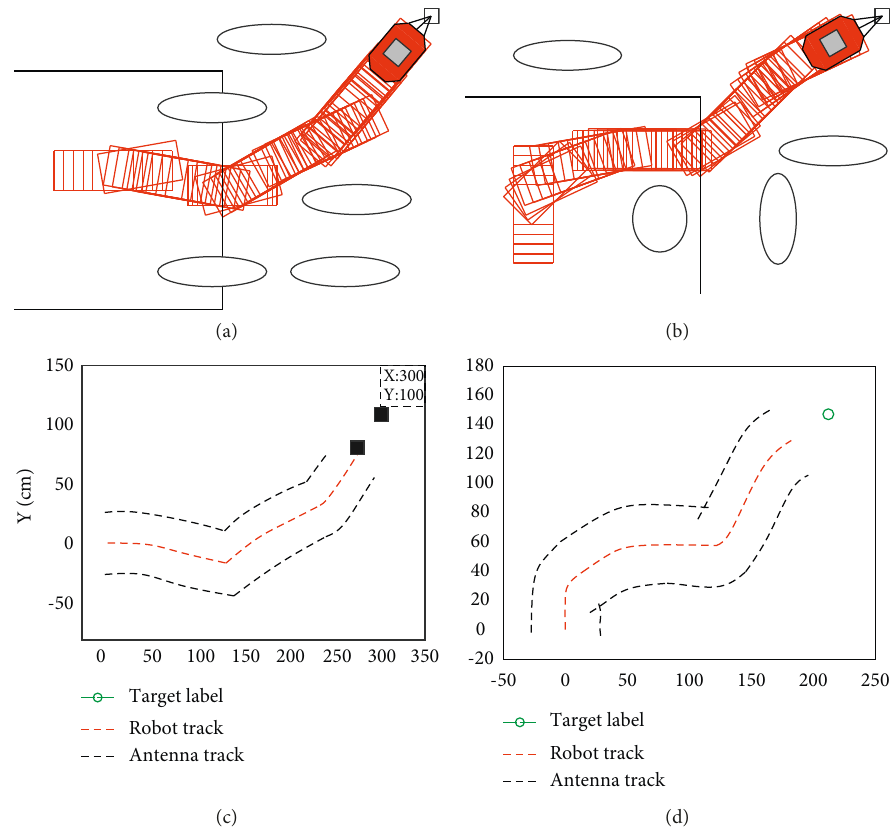
Figure 9: Obstacle avoidance trajectory in different poses. (a) Initial orientation angle of 0 ° , target location (300, 100). (b) Initial orientation angle of 90 ° , target location (210, 150). (c) Initial orientation angle of 0 ° , target location (300, 100). (d) Initial orientation angle of 90 ° , target location (210, 150).